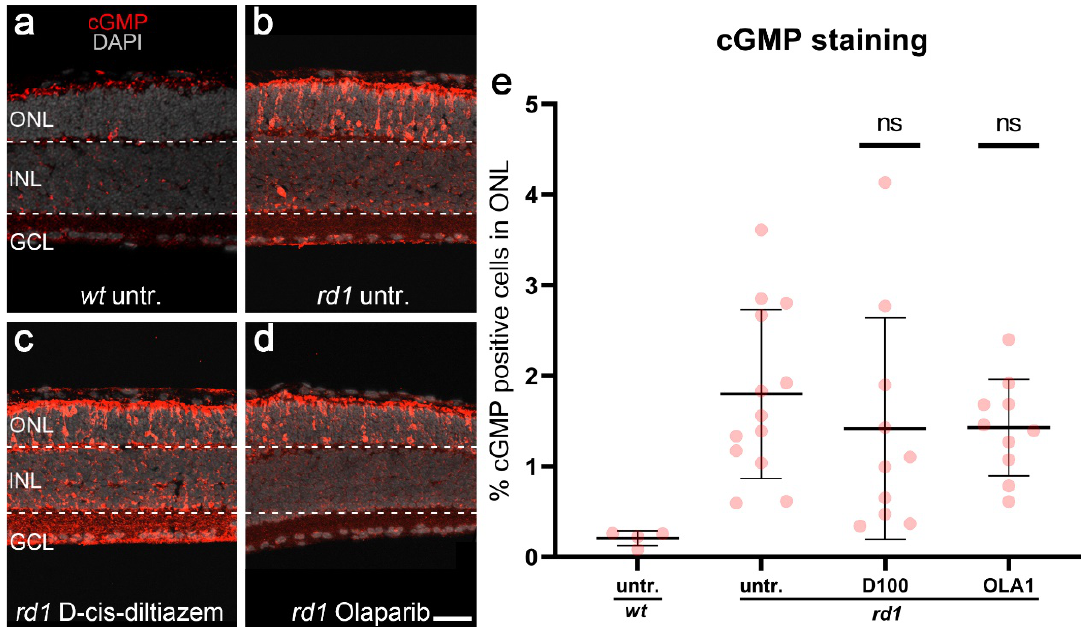
Scheme A3. Photoreceptor accumulation of cGMP in different experimental conditions. cGMP immunostaining (red) was used in wt and rd1 retinal explant cultures. DAPI (grey) was used as a nuclear counterstain. In wt retina (untr.; a ), only a few cells in the outer nuclear layer (ONL) were labeled cGMP-positive. rd1 control retina (untr.; b ) was compared to retina treated with either 100- µ M D-cis-diltiazem (D100, c ) or 1- µ M Olaparib (OLA1, d ). Statistical significance was assessed using one-way ANOVA, and Tukey’s multiple comparison post hoc testing was performed between control, 100- µ M D-cis-diltiazem (D100), and 1- µ M Olaparib (OLA1). Note the large numbers of cGMP expressed in the rd1 ONL. The scatter plot ( e ) shows the percentage of cGMP-positive cells in the ONL. Neither D-cis-diltiazem or Olaparib reduced the cGMP-positive cells. Untr. wt : 4 explants from 2 different mice; untr. rd1 : 13/13; D100 rd1 : 10/10; OLA1 rd1 : 10/10; error bars represent SD; ns = p > 0.05. INL = inner nuclear layer, GCL = ganglion cell layer. Scale bar = 50 µ